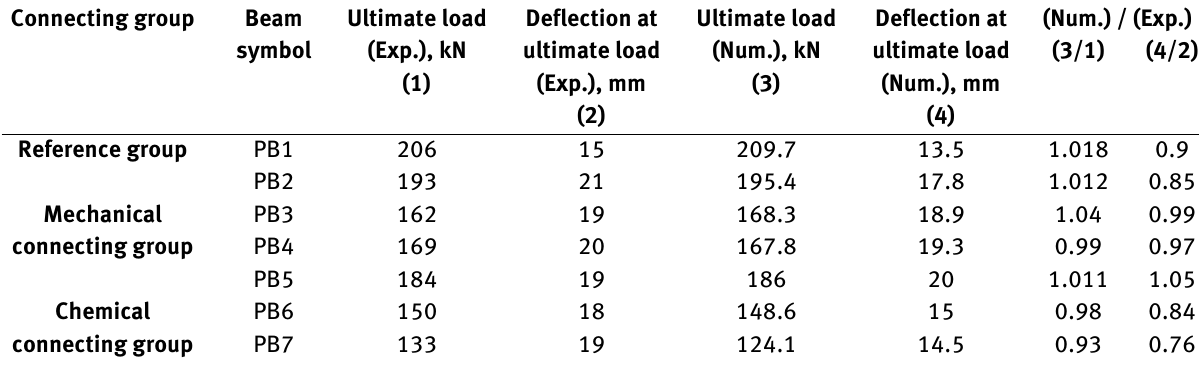
Table 5: The experimental and numerical results of ultimate loads and their midspan defections Connecting